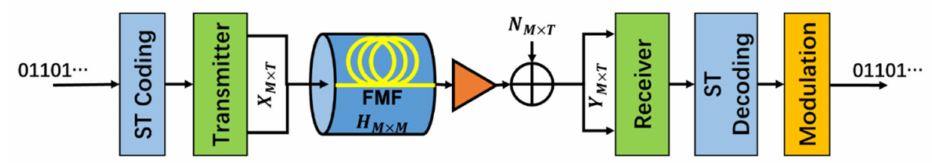
Figure 12. SDM transmission system with STC technique.